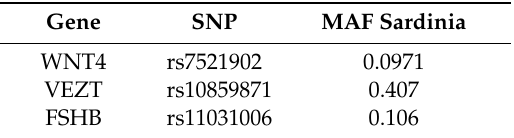
Table 8. Minimum allelic frequency (MAF) in Sardinian population of single nucleotide polymorphisms (SNPs) under investigation. WNT4, wingless-typemammalian mouse tumour virus integration site